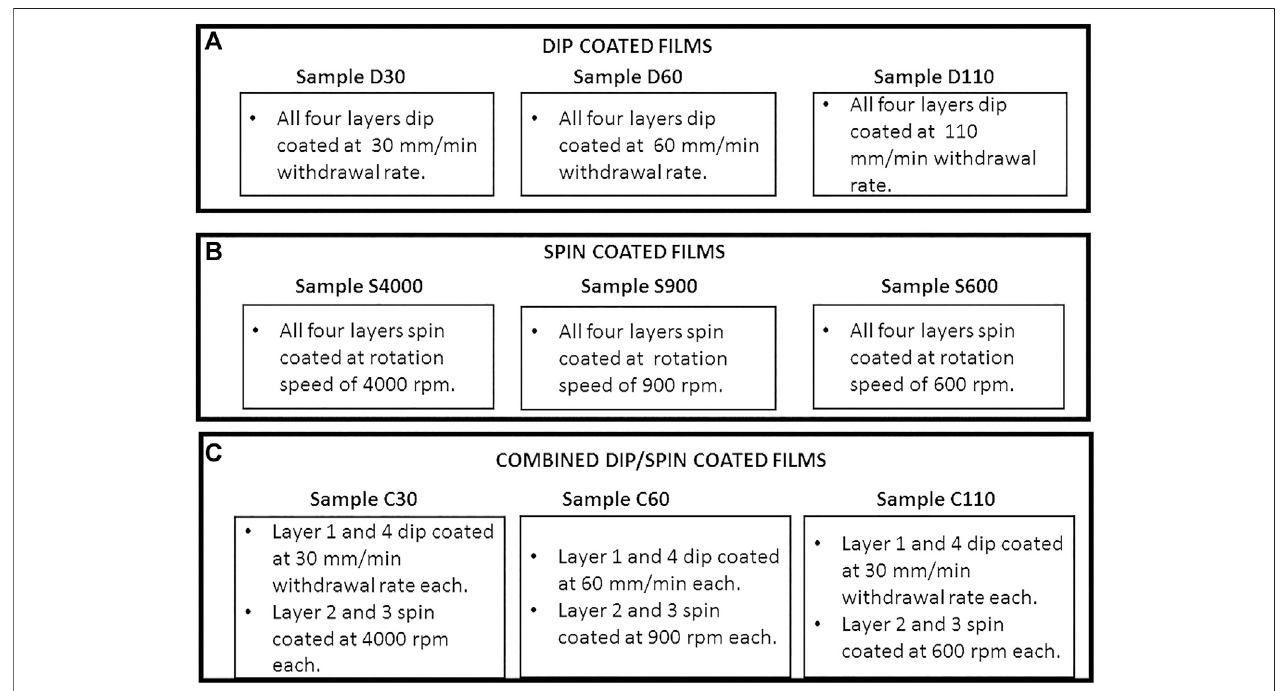
FIGURE 1 | An illustration summarizing the rotation speeds and/or withdrawal rates used while preparing the different layers of (A) dip, (B) spin and (C) dip/spin coated samples respectively.